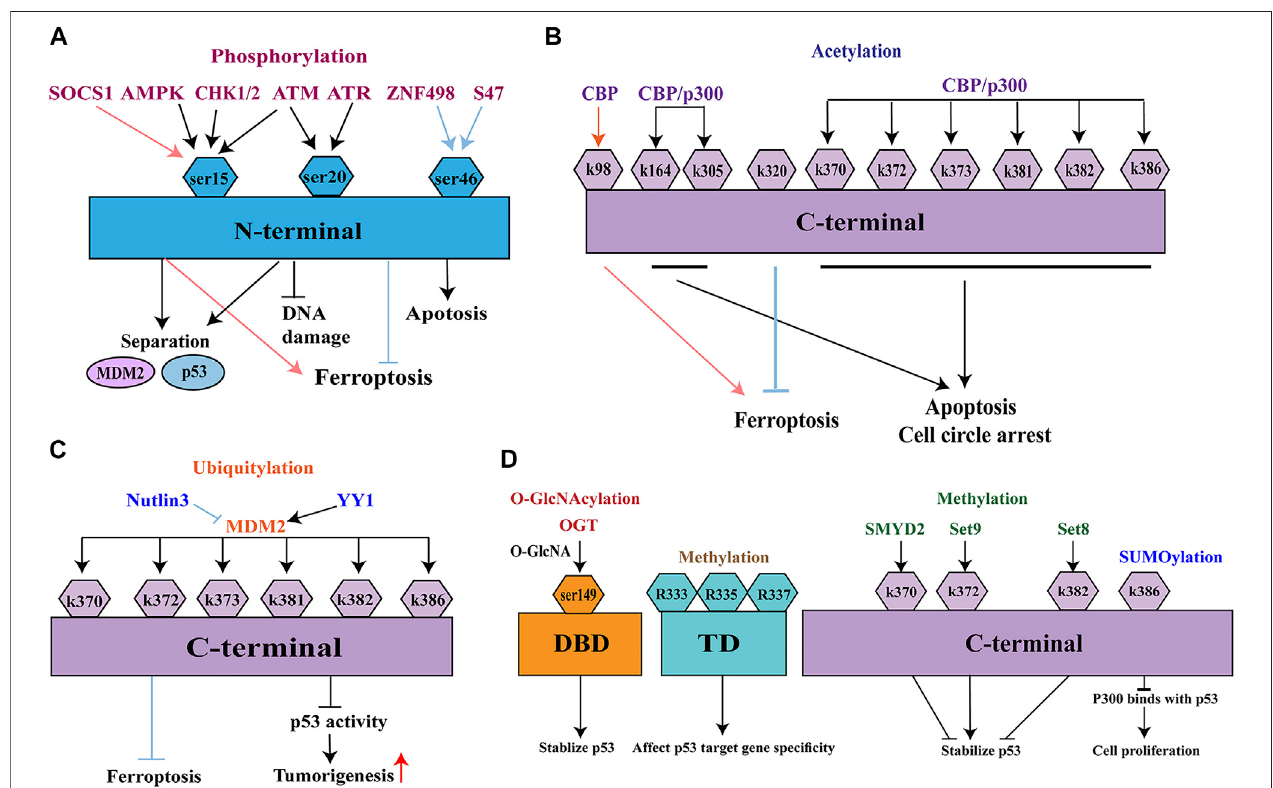
FIGURE 4 | Post-translational modi fi cations of p53. (A) phosphorylation; (B) acetylation; (C) ubiquitination; (D) O-GlcNAcylation, SUMOylation, and methylation. MDM2, Murine double minute-2; ATM, ataxia-telangiectasia mutated kinase; ATR, ATM-and Rad3-related kinase; CHK1/2, checkpoint kinase 1/2; AMPK, adenosine monophosphate-activated protein kinase; CBP, CREB binding protein; EP300/p300, E1A binding protein P300; PCAF, p300/CBP-associated factor; KAT5/Tip60, lysine acetyltransferase 5; KAT8/MOF, lysine acetyltransferase 8; MOZ, monocytic leukemia zinc fi nger; YY1, Yin Yang